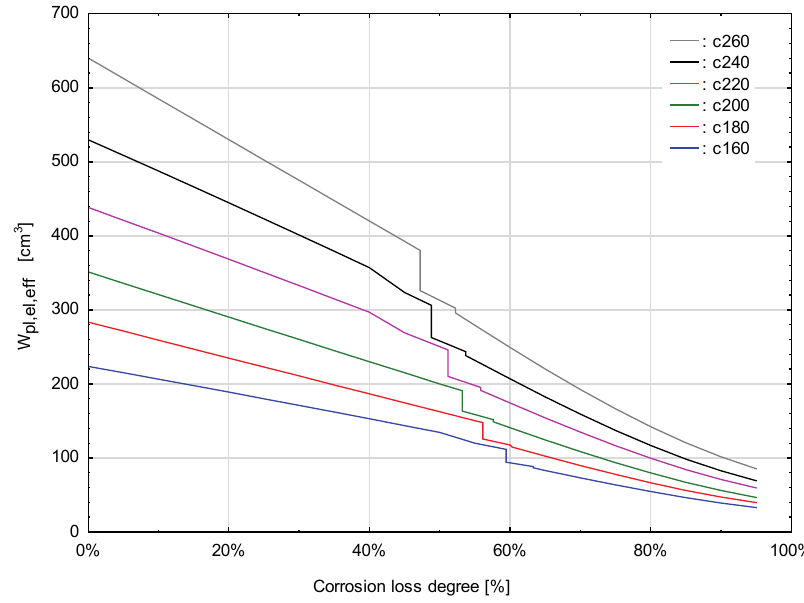
Fig. 3. The dependence of the section modulus as a function of corrosion